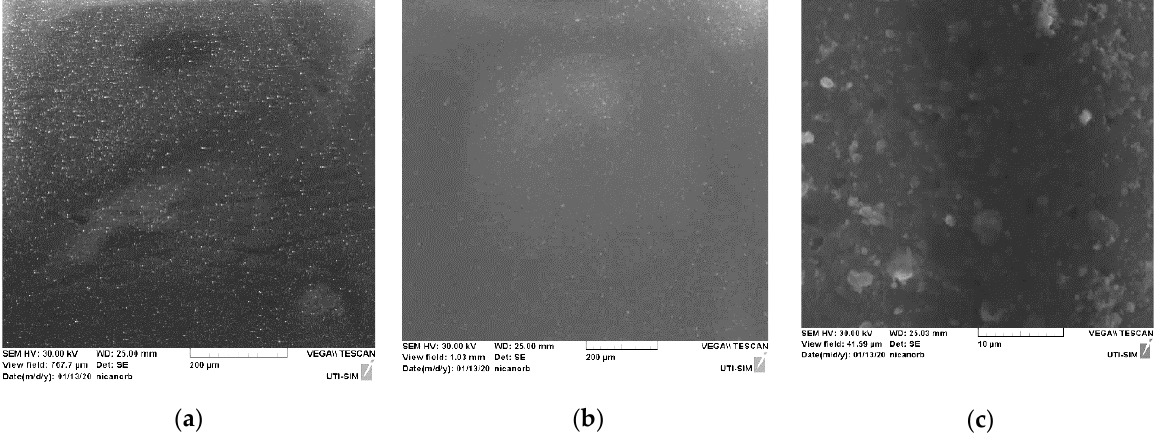
Figure 5. SEM images of oyster shell 250× magnified ( a ), PLD thin film 200× magnified ( b ) and PLD thin film 5k× magnified ( c ).